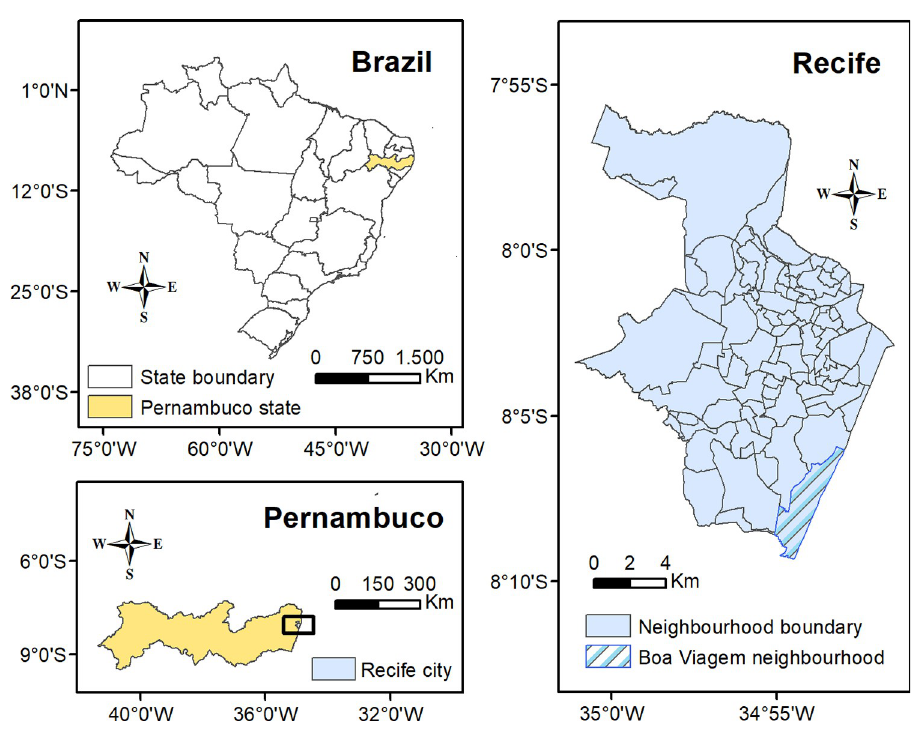
Fig 2. Location of the study area. Sources: Brazilian Institute of Geography and Statistics (IBGE) 2021, and software ArcGIS 10.4.1.